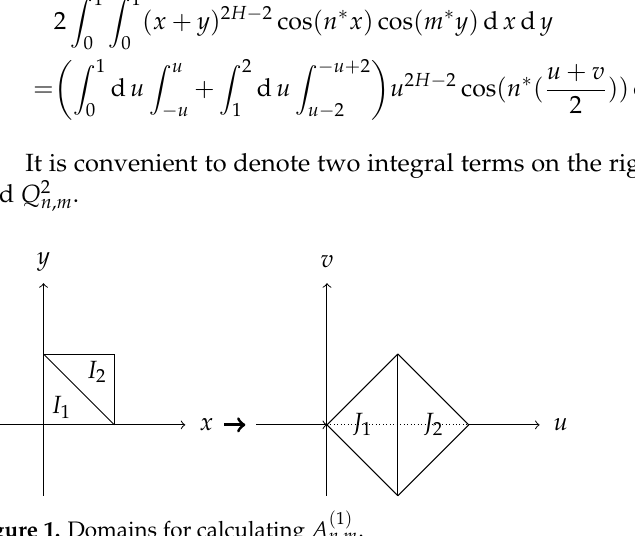
Figure 1. Domains for calculating A